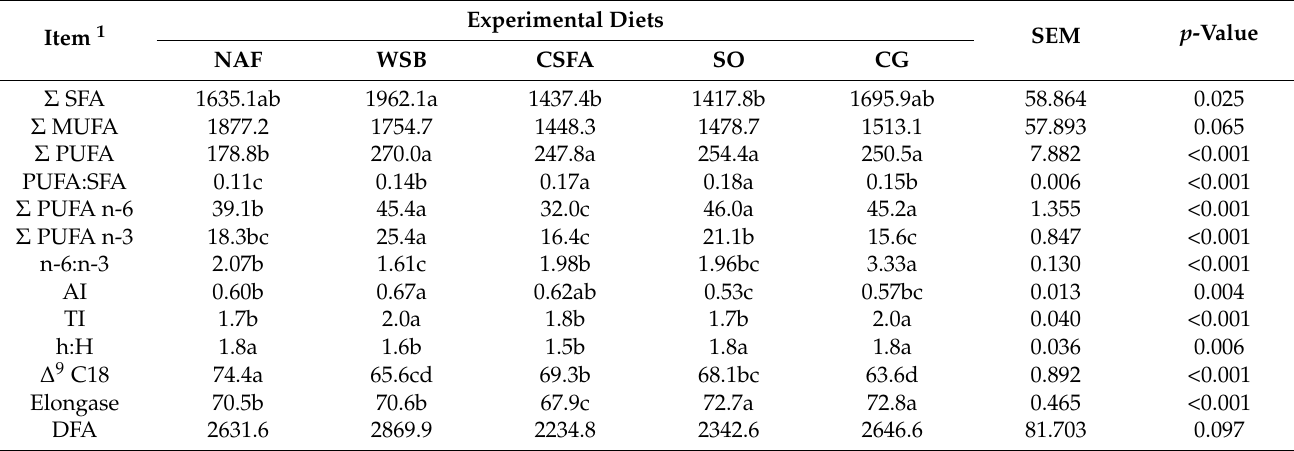
Table 7. Fatty acid classes (mg/100 g of meat), ratios, indexes, and enzyme activity in the LL muscle of lambs fed diets containing different fat